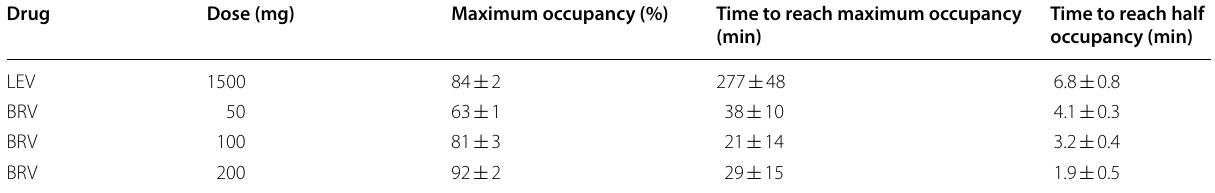
Table 4 Maximum target occupancies by AEDs and time to reach maximum and half occupancy after AED administration